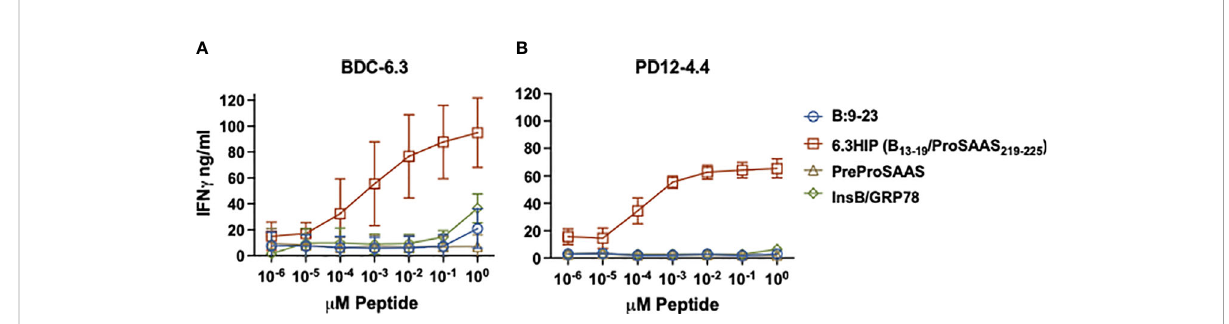
FIGURE 3 IFN- g responses of T cell clones to parent peptides and B-chain HIPs. Stimulation of T cell clones BDC-6.3 (A) and PD12-4.4 (B) with titrations (0.00001 - 10 m M) of individual left (B:9-23) and right (PreProSAAS 212-225 ) components of the 6.3HIP (B 13-19 /ProSAAS 219-225 ), the 6.3HIP and B- chain HIP InsB/GRP78 335-340 . Blue open circle = B:9-23, red open square = 6.3HIP, brown open triangle = PreProSAAS 212-225 , green open diamond = InsB/GRP78 335-340 . Compiled data is shown for the mean ± SD of 3-5 experiments (BDC-6.3) and 3-4 experiments (PD12-4.4). Data is expressed as IFN- g ng/ml.